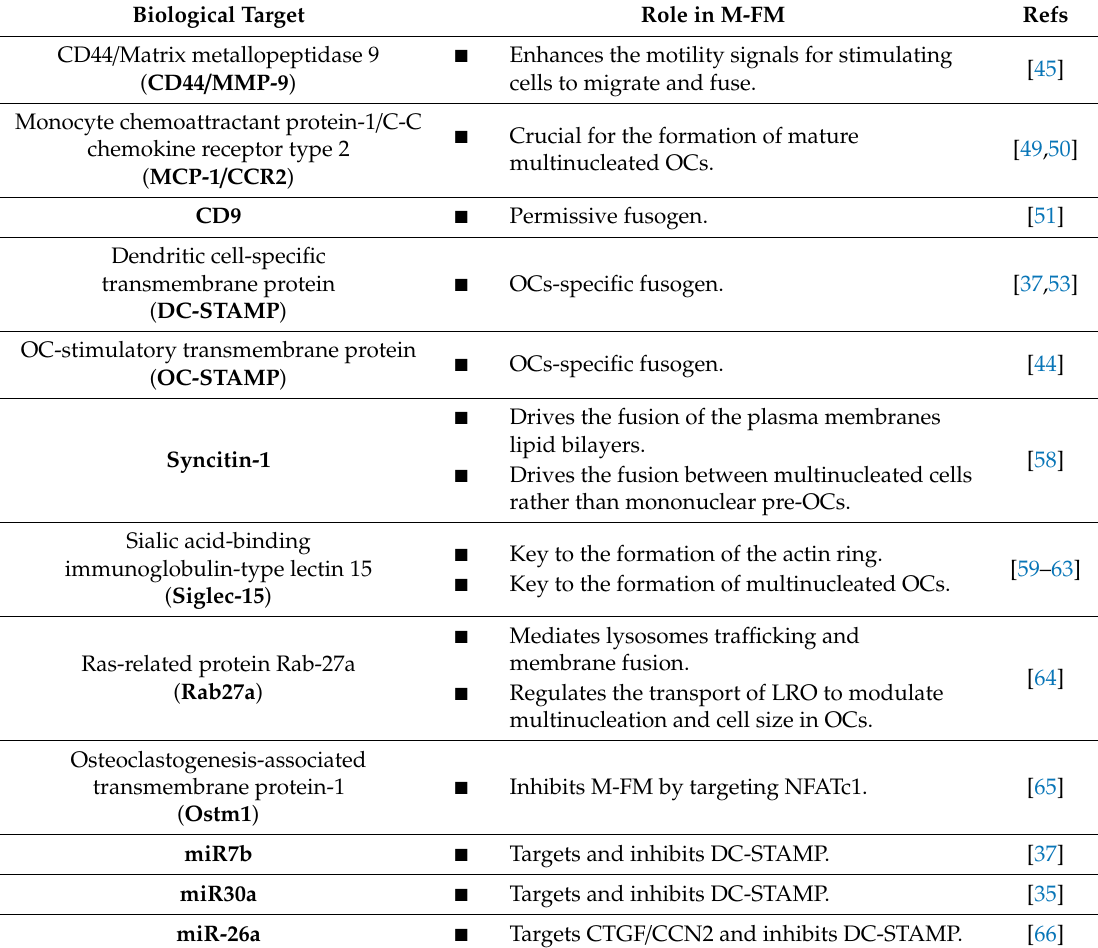
Table 1. Biological targets involved in monocyte-macrophages fusion and multinucleation (M-FM). Biological Target Role in M-FM